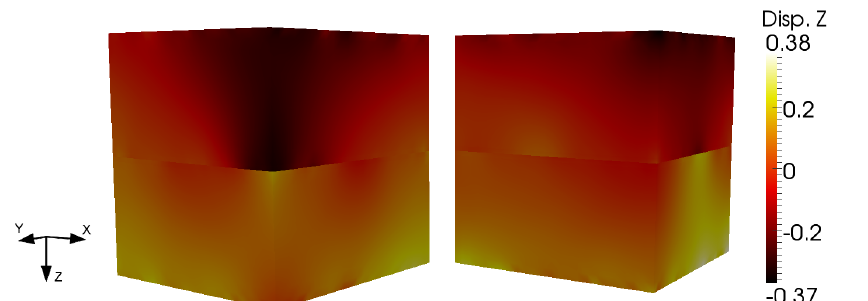
Figure 2: Mode I component of the displacement field of the corner crack after 180kc (left) and the surface crack after 200kc (right): X-DVC analysis. The scale is given in voxel (1voxel= 3.5µm).